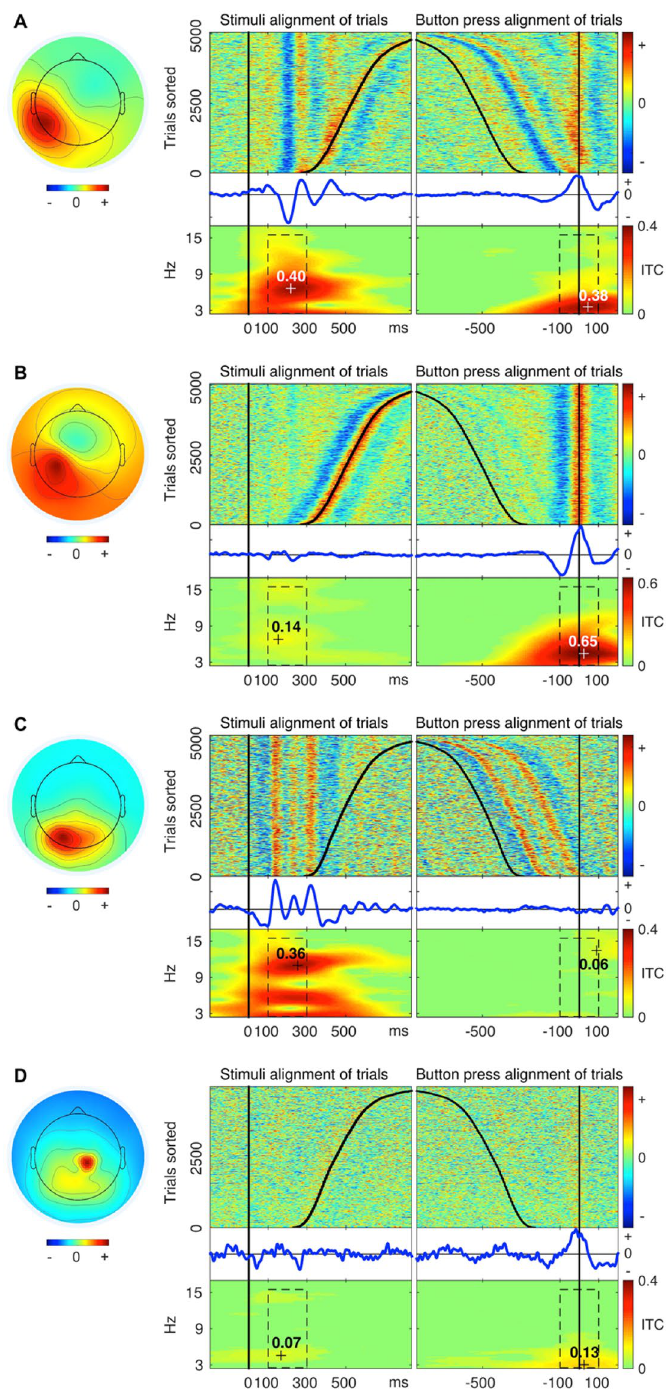
Figure 3. Examples of ( A ) Sensorimotor, ( B ) Motor, ( C ) Sensory, and ( D ) Unspecified ICs. The exact procedure of grouping of all ICs into the four groups is described below. The round component scalp maps on the left side represent topography of ICs from 64-channel EEG recordings. The component scalp map values returned by ICA were proportional to µ V (scaling is distributed between the component maps and activity time courses) 26, 33 . Panels on the right side of each scalp map depict activity data of the IC. (1) The “top-left” plot in each panel shows colour-coded amplitude of the IC activity in a recording session. Each line in the plot represents a trial. Trials were sorted according to latency of reaction time. The black vertical line (OX = 0 ms) shows the onsets of the stimuli and the black curve in the positive direction shows the moments of a button-press event. (2) The “top-right” plot in each panel depicts the same trials as the “top-left” plot, but this time trials were aligned by onset of a button-press event (OX = 0 ms). The straight vertical line shows the moments of the button-press events and the curve in the negative direction shows the onsets of the stimuli. (3) The “middle-left” and (4) “middle-right” plots in each panel show Event Related Potentials (blue curves) derived from trials depicted